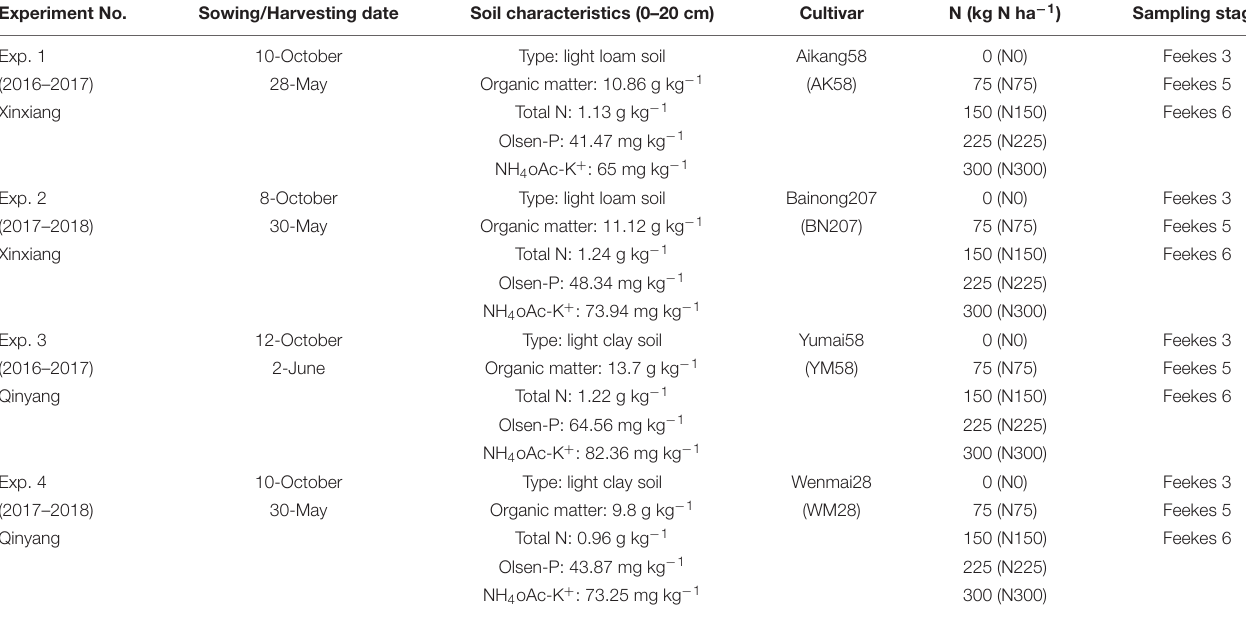
TABLE 1 | Basic information about four field experiments conducted during 2016 and 2018 growing seasons at Xinxiang and Qinyang. Experiment